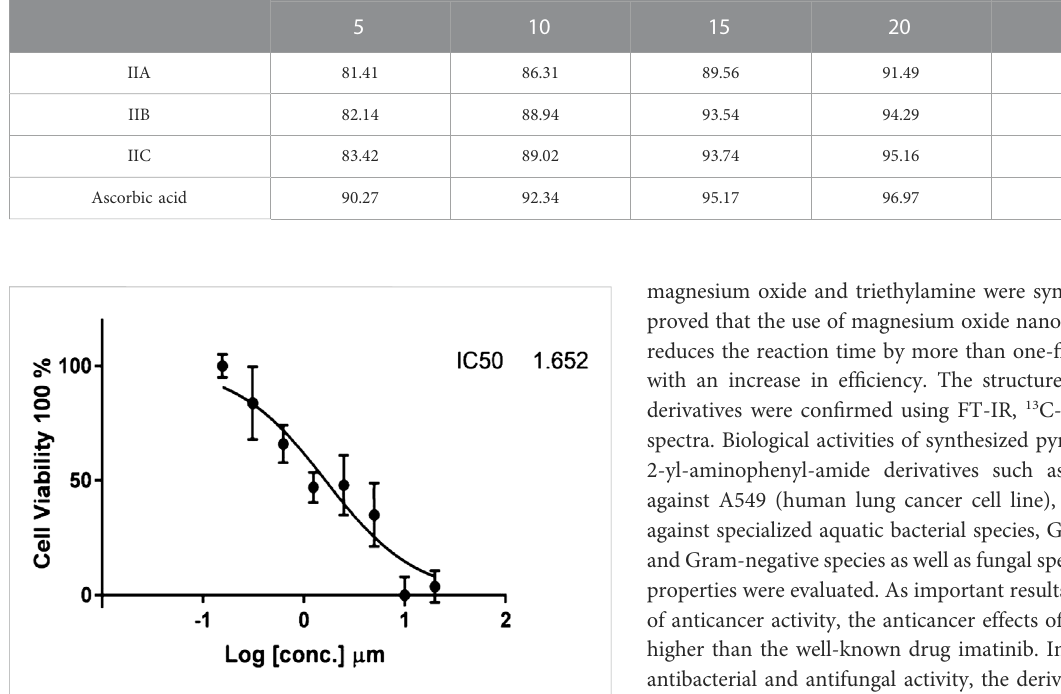
FIGURE 8 Viability test of compound IIC against the A549 cell line.